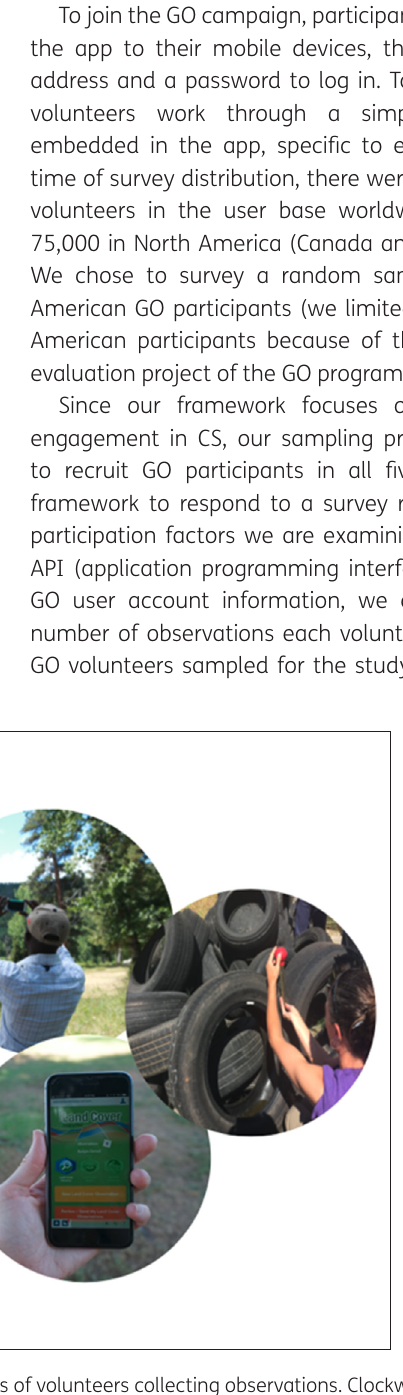
Figure 3 GLOBE Observer (GO) mobile application interface and photos of volunteers collecting observations. Clockwise from the top, GO volunteers observing clouds for the GLOBE Clouds protocol, GO volunteer counting mosquito larvae for the Mosquito Habitat Mapper protocol, and a GO volunteer beginning to make an observation with the Land Cover protocol tool. The simplest and most popular Cloud protocol asks volunteers to identify clouds and take photos of the sky. In contrast, the Mosquito Habitat Mapper protocol is more labor- intensive. It asks volunteers to identify mosquito larvae and take photos of them, with the option to use additional equipment (a magnifier zoom lens and mosquito trap). The Land Cover protocol asks volunteers to take pictures of their surrounding land cover and optionally classify the types of land cover they have captured. Photos courtesy of Autumn Burdick, NASA GLOBE Observer Communications